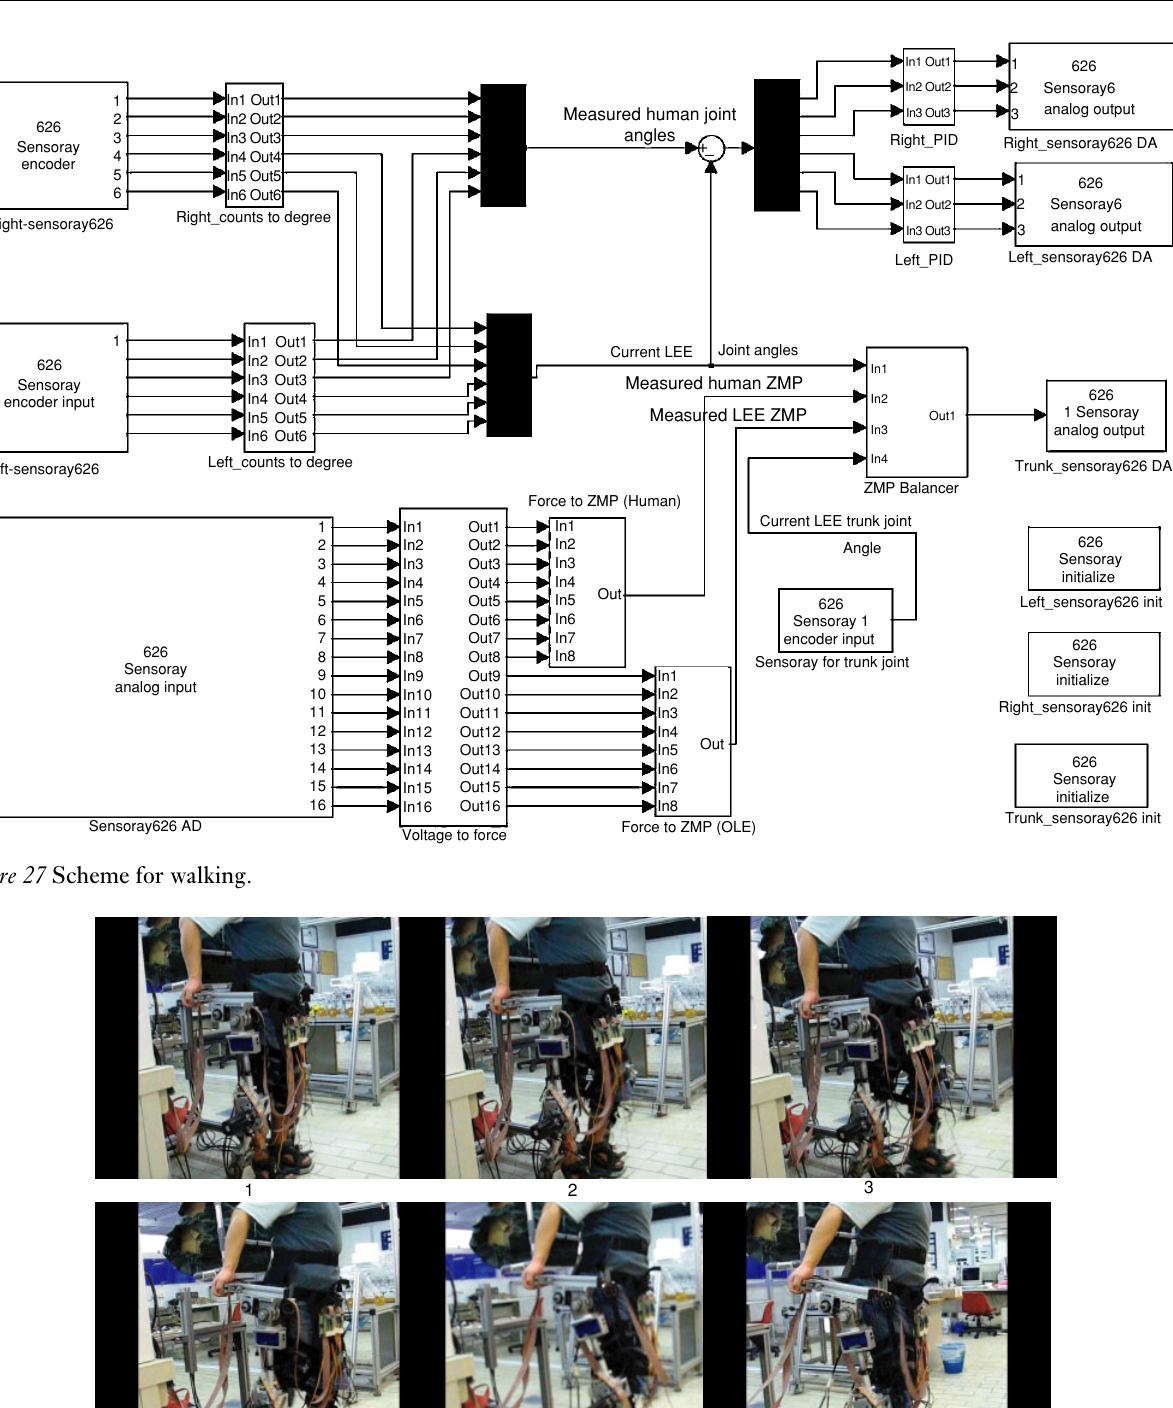
Figure 28 Snapshots of a walking test with a person carrying payload. Figure 24 shows the responding of LEE’s left knee joint during one walking test. The two upper curves represent- ing the inner exoskeleton and the LEE (outer exoskele- ton) are quite close to each other, while the lower line